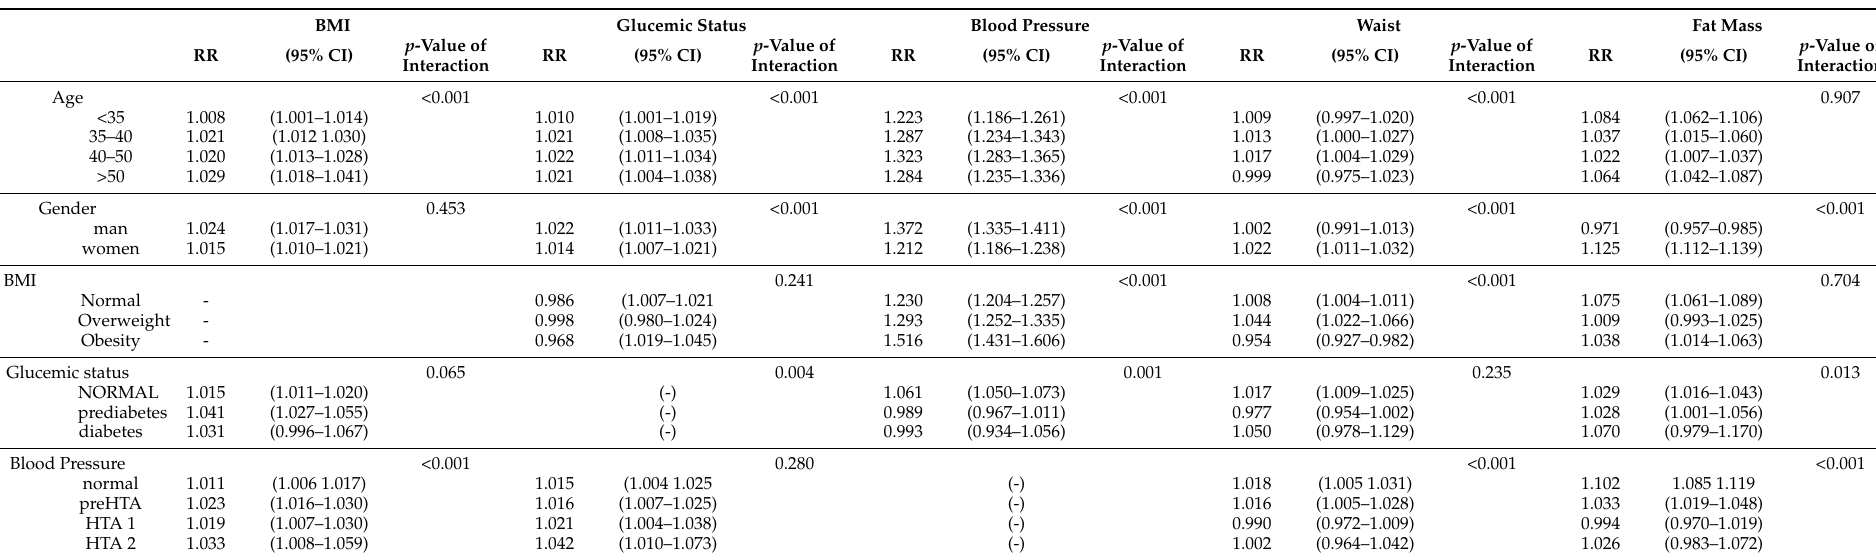
Table 3. Relative risk of patients with increased BMI, waist, fat mass, glycemic status, and hypertension status divided into categories of age, sex, BMI, glycemic status, and hypertension status. Patients were considered to have worsened when they changed to an upper category in the corresponding risk factor: BMI (normal, overweight, obesity); glycemic status (normal, prediabetes, diabetes); blood pressure status (normal, pre-AHT, AHT1, AHT2); waist (normal, high); fat mass (normal, high, very high); total cholesterol (normal, high); LDL (normal, high); HDL (normal, low); TG (normal, high).